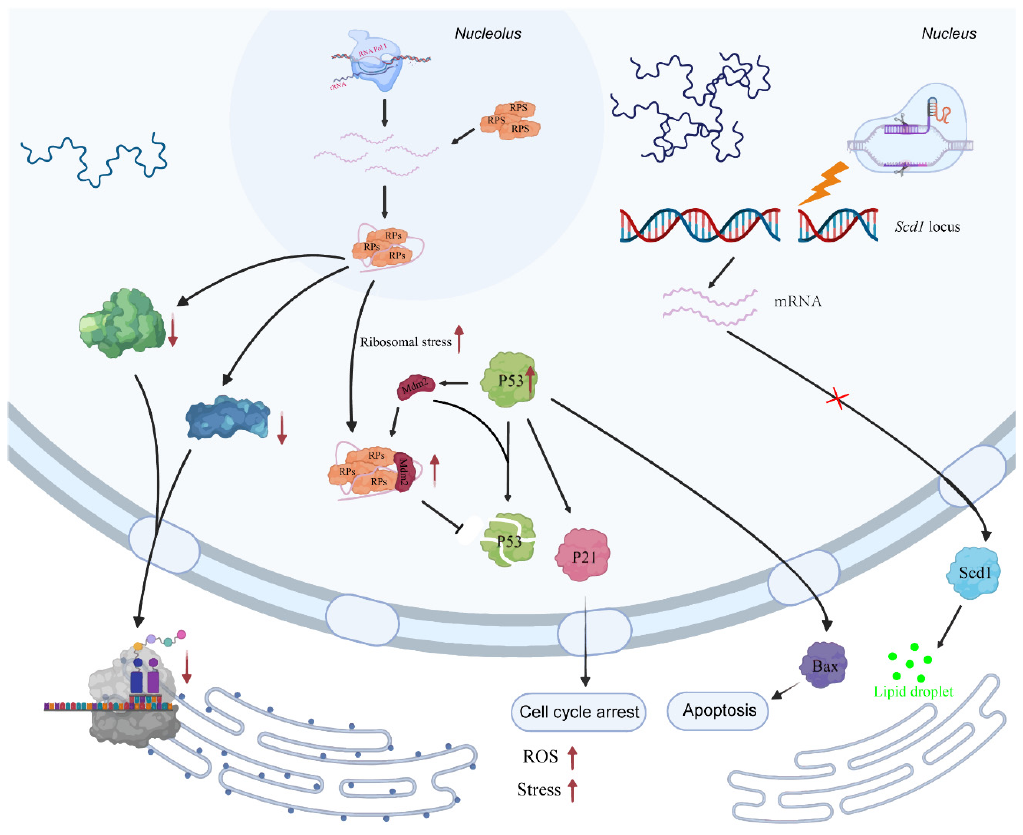
Figure 7. Overview of the molecular processes occurring after Scd1 knock out. A schematic illustration showing that knockout of Scd1 gene triggered insufficient of lipid droplet. Then the RPs-Mdm2-P53 pathway was activated, and genes related to apoptosis and cell cycle arrest were upregulated, leading to the increasing of ROS and ribosome stress, and inhibiting of ribosome biogenesis and embryonic developmental arrest. RPs: r-protein, including RPL and RPS, which bind to rRNA and form the large and small subunits of the ribosome,